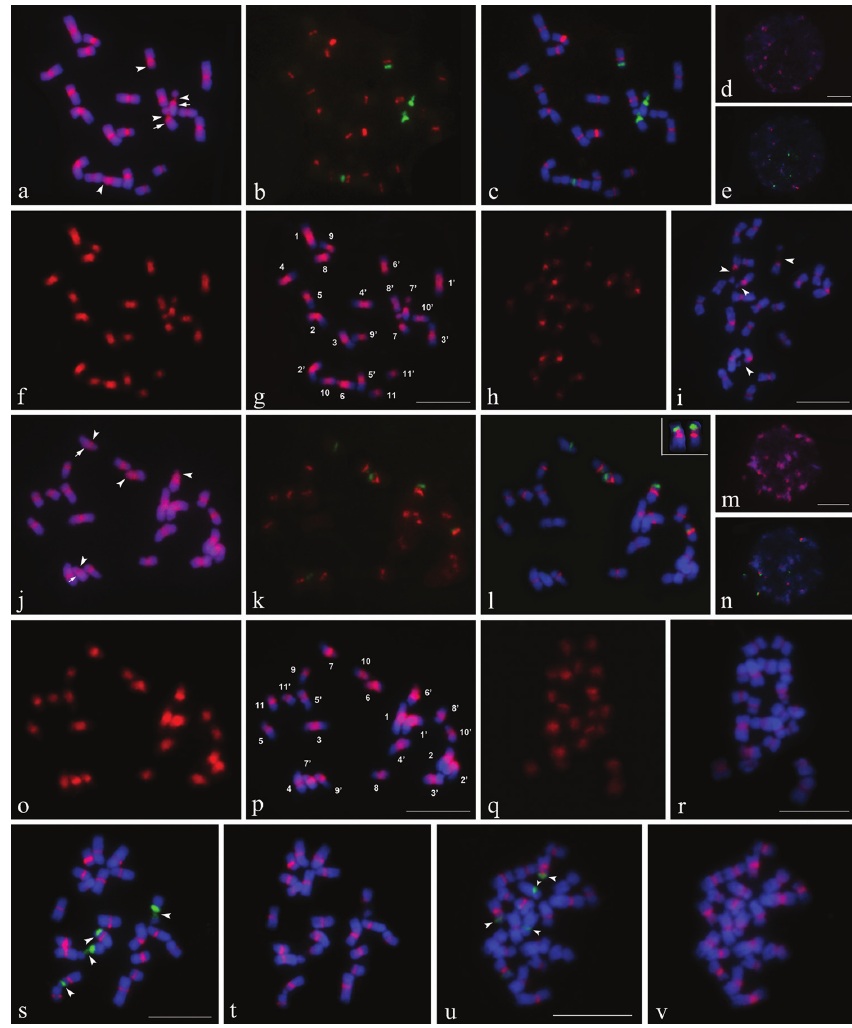
Figure 2. Mitotic chromosomes (except for d, e, m, n ) and interphase nuclei ( d, e, m and n ) of Ca- navalia gladiata ( a–i, s, t ) and Canavalia ensiformis ( j–r, u, v ) after sequential CPD staining and in situ hybridization. a, d, j, m CPD-stained chromosomes and interphase nuclei. c, e, l, n, s, u Chromosomes and interphase nuclei showing 5S (red) and 45S (green) rDNA signals produced by digoxigenin-labeled 5S rDNA and biotin-labeled 45S rDNA probes. b and k 5S and 45S rDNA signals only. f and o Signals produced by digoxigenin-labeled total genomic DNA of their own, g and p Chromosomes with sGISH signals. h and q Signals produced by digoxigenin-labeled total genomic DNA probes from other species. i and r Chromosomes with cGISH signals. t and v FISH of digoxigenin-labeled 5S rDNA repeats cloned from C. gladiata and C. ensiformis to same spreads shown in s and u , respectively. Arrows in a and j in- dicate positions of pair 7 centromeres. Arrowheads in a, i, j, s and u indicate distinguishable secondary constrictions (SC). Chromosome numbers in g and p are designated by karyotyping. Chromosomes in upper right corner of l are pair 6 from another spread showing proximal 5S rDNA loci on short arms. Chromosomes were counterstained using DAPI (blue). Bars = 10